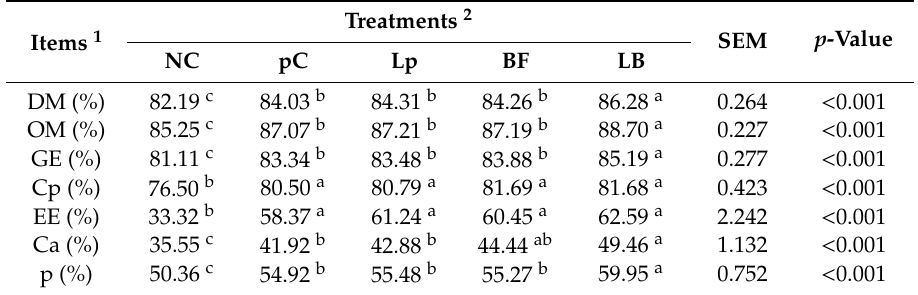
Table 3. E ff ects of L. plantarum , tartary buckwheat flavones, and their compound on nutrient digestibility of weaned